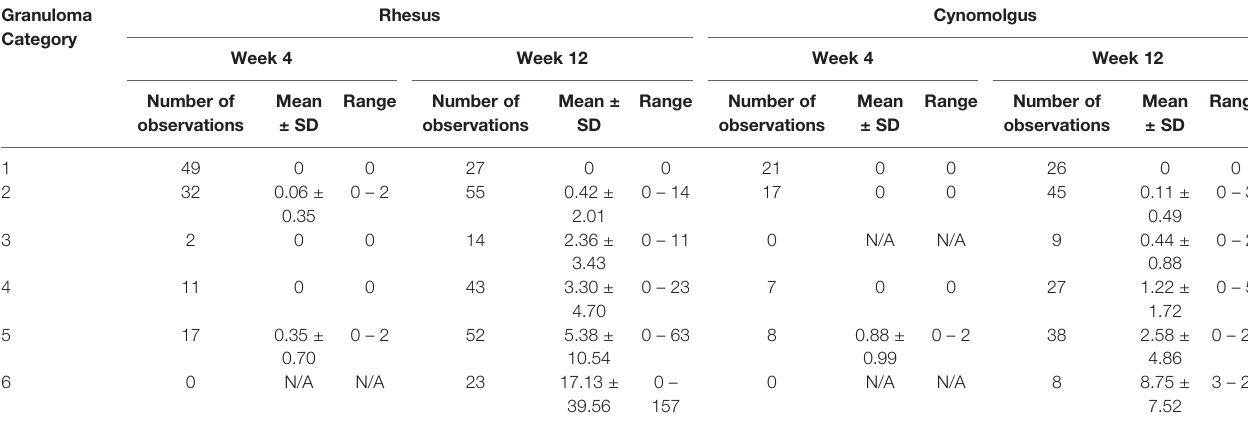
Number of observations = number of granulomas counted in all granuloma categories at each time point. Range = range of MNGCs observed in granulomas. Mean = mean number of MNGC observed ±